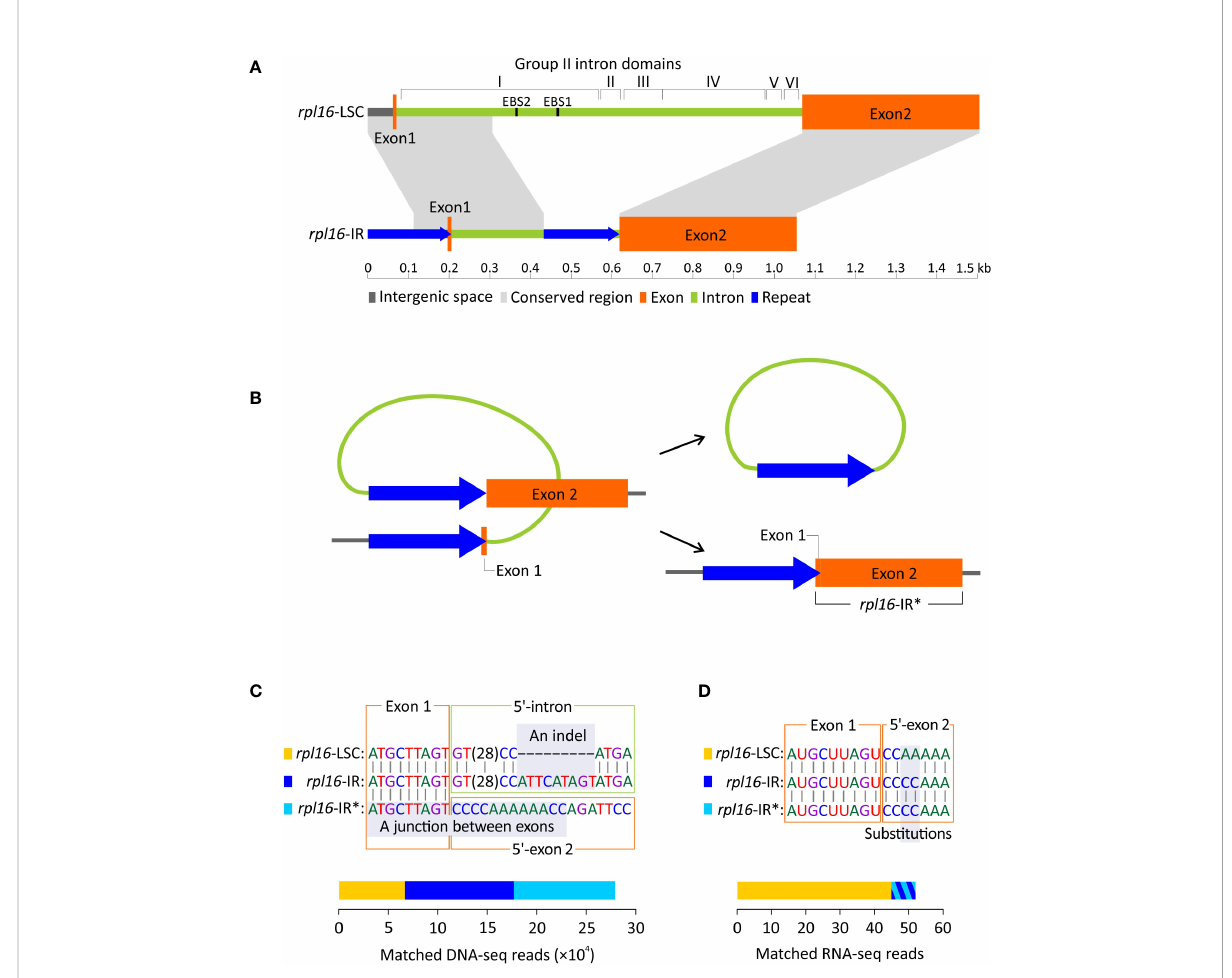
FIGURE 5 Duplication of rpl16 in Dichondra . (A) Comparisons of rpl16 copies residing in the LSC ( rpl16 -LSC) and IR ( rpl16 -IR) regions. The rpl16 -LSC harbors a typical group II intron containing I − VI domains, while the rpl16 -IR is short and degraded with only partial sequences of the domain I (B) A hypothetical scenario for loss of the rpl16 -IR intron via homologous recombination between direct repeats. The intron-lacking rpl16 -IR is therefore designated as rpl16 -IR*. (C) DNA-seq mapping analyses showing the coexistence of three rpl16 copies (color-coded) in Dichondra . Regions enabling copy discrimination are highlighted with grey and indicated with the terms “ An indel ” and “ A junction between exons ” . Stacked bars are the number of reads matching speci fi c copies. (D) RNA-seq reads mapped to putative transcripts of the three rpl16 copies after splicing. The bars for rpl16 -IR and rpl16 -IR* are added together because they are not distinguishable by highlighted